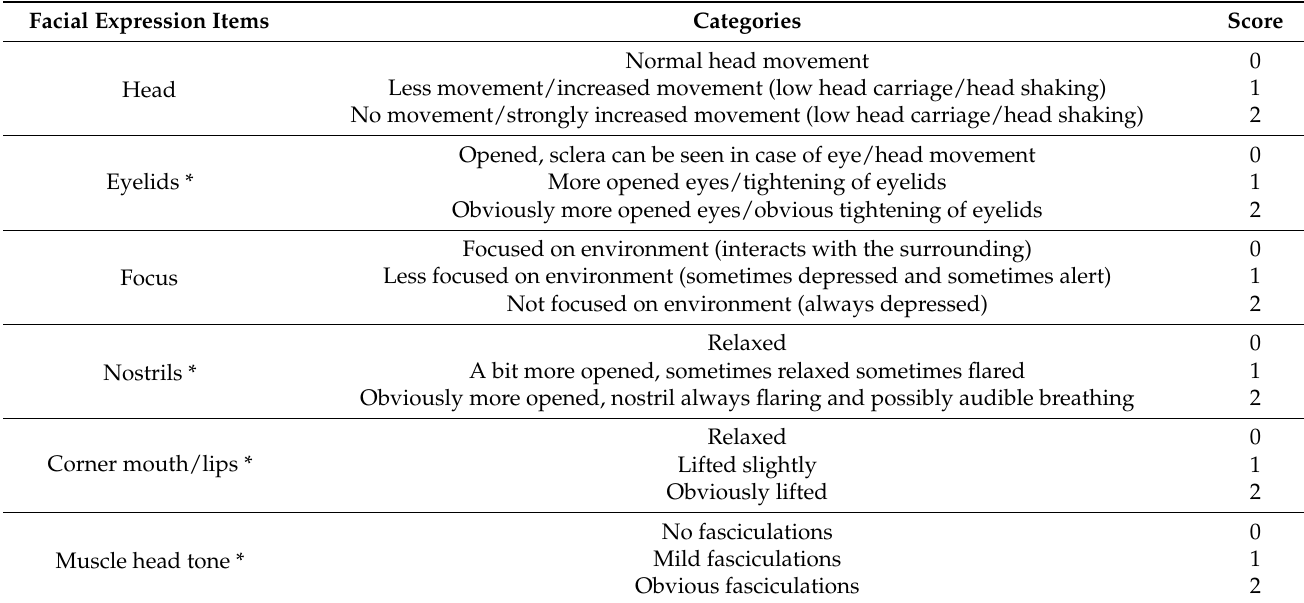
Table 3. Score sheet of the Section I of FCPS: Facial expressions. This Section was extracted